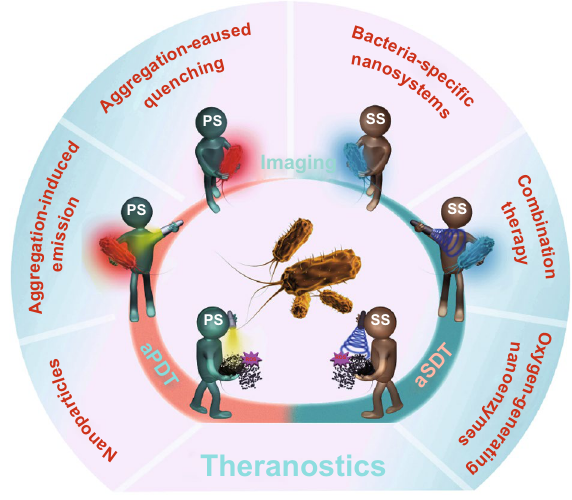
Fig. 1 Schematic illumination of aPDT and aSDT for bacterial thera- nostic application. Bacterial imaging can be accomplished facilely with the inherent optical characteristics of photo/sonosensitizers, and the generated ROS of aPDT/SDT cause broad-spectrum oxidative damage for sterilization. PS photosensitizer, SS sonosensitizer